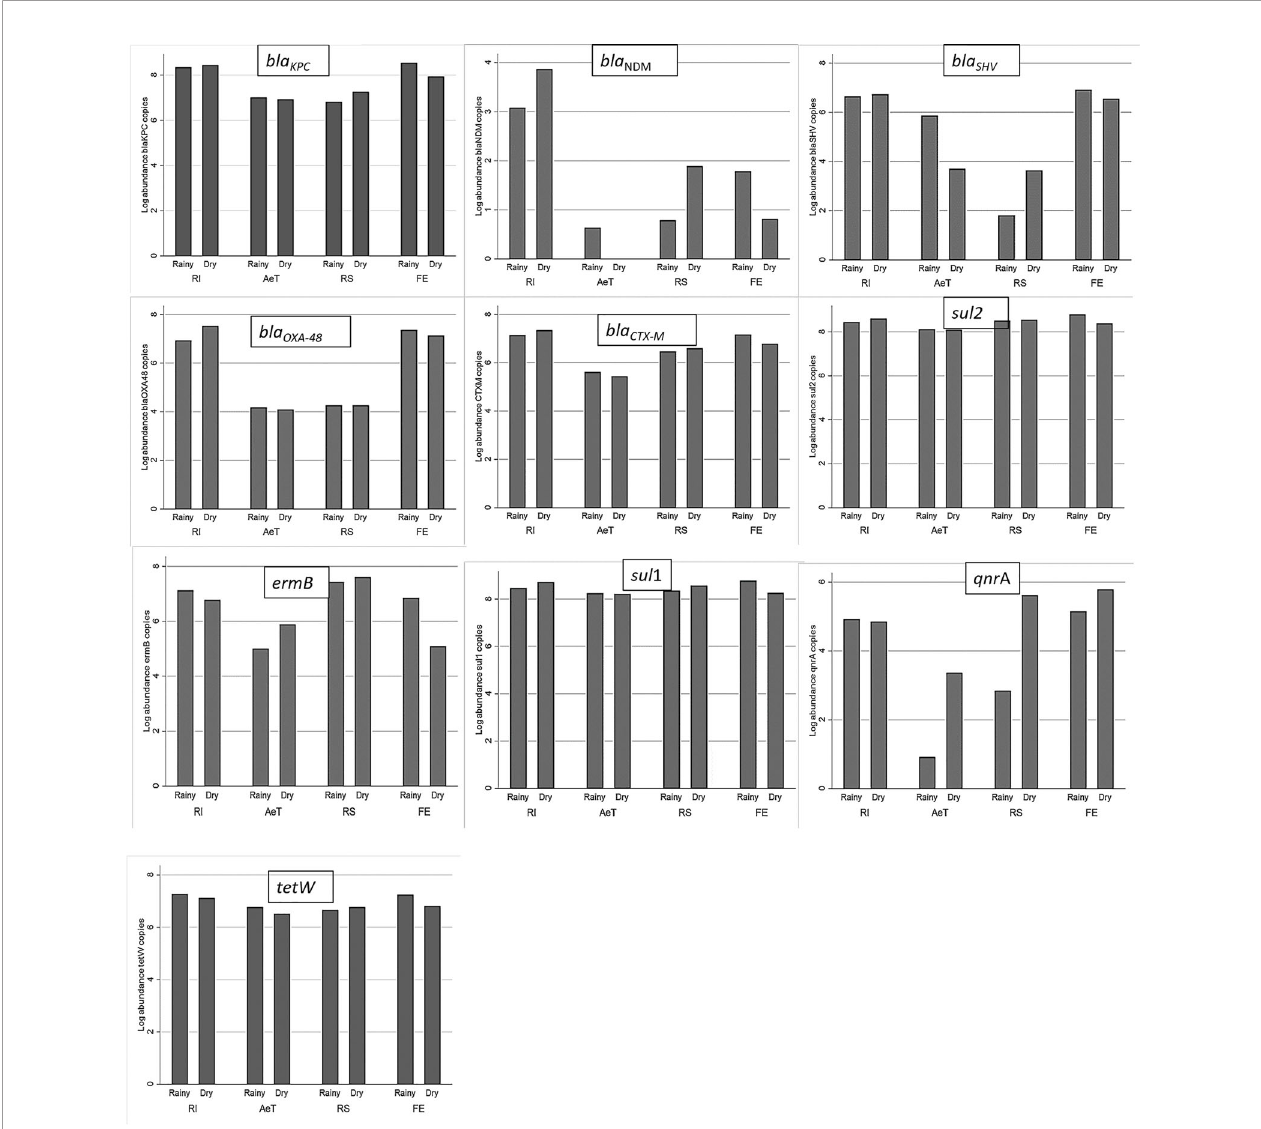
FIGURE 5 | Absolute concentration of each ARG in samples collected from RI, AeT, RS, and FE in both rainy and dry seasons. The data represent the average concentrations of ARGs. The results are expressed in log 10 copies per